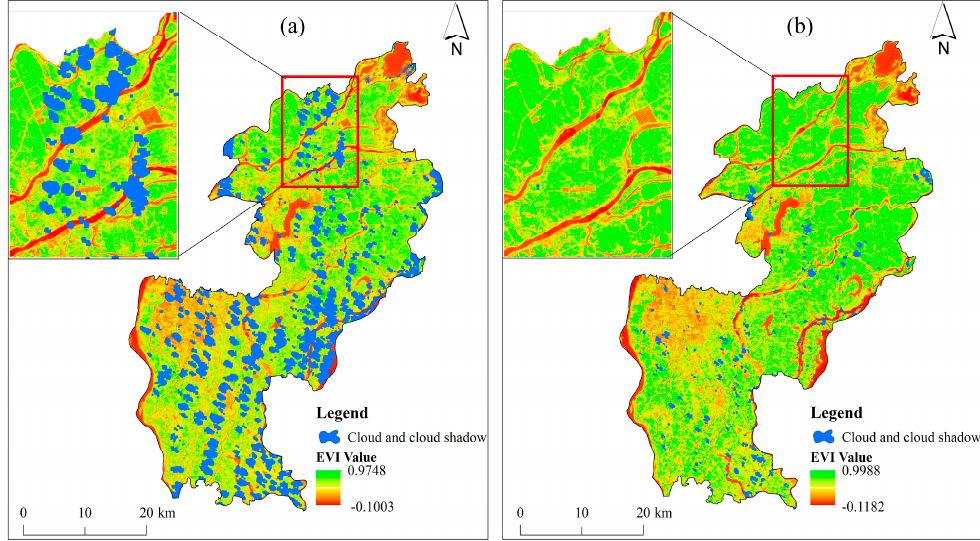
Figure 8. Elimination of the influence of clouds by replacing the regions contaminated by clouds and cloud shadows with fusion EVI values. ( a ) The raw EVI value and ( b ) the fused EVI value.